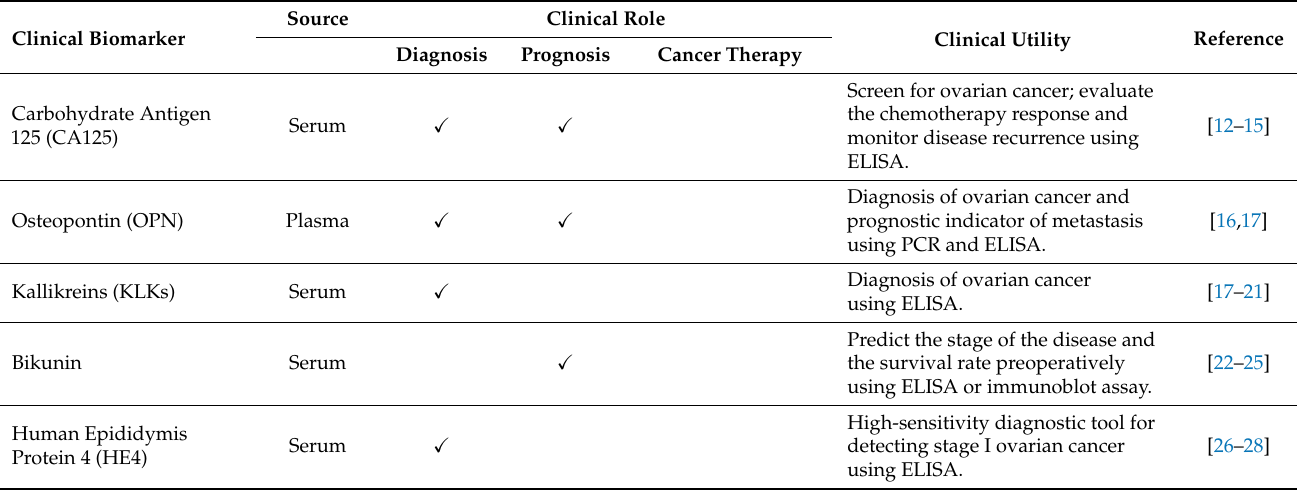
Table 1. Current ovarian cancer biomarkers and their clinical